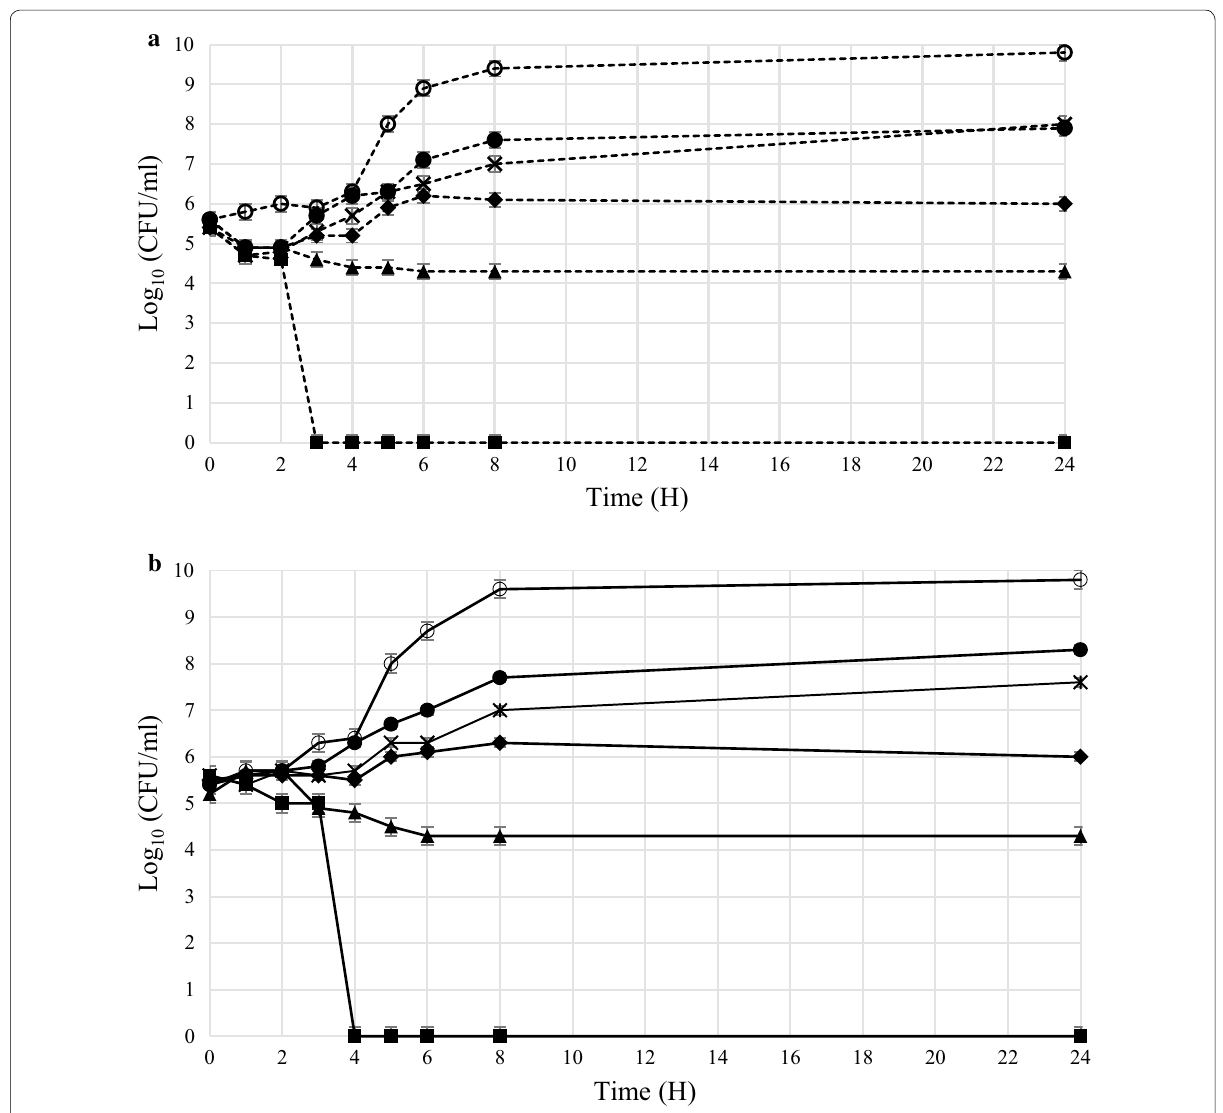
Fig. 3 Time-kill curves of wildtype ( a ) and recombinant Streptococcus suis ParB-GFP ( b ) after treatment with rhodomyrtone at 1 µg/ml (filled square), 0.5 µg/ml (filled triangle), 0.25 µg/ml (filled diamond), 0.125 µg/ml ( negative control. The results were shown as